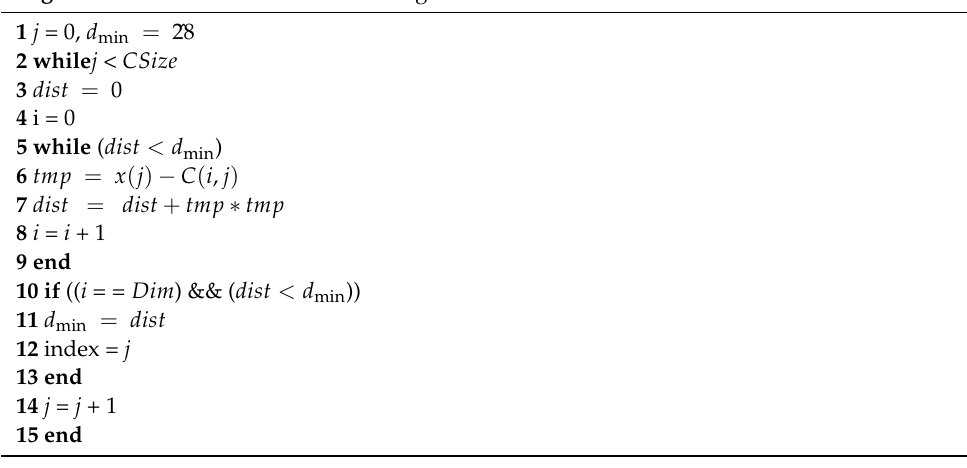
Algorithm 2. Pseudo-code of the PDE algorithm